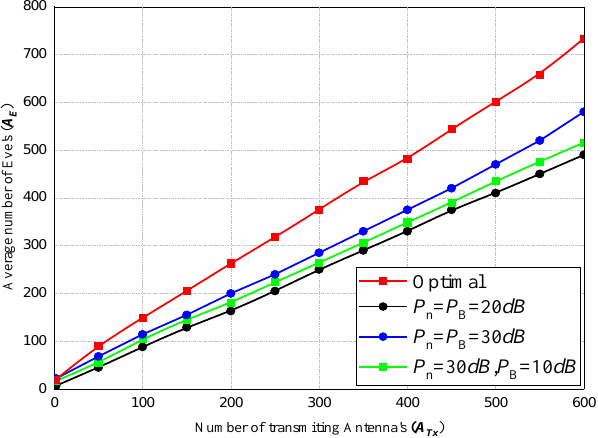
Figure 11. Comparison of ¯ A E versus ¯ A Tx with different